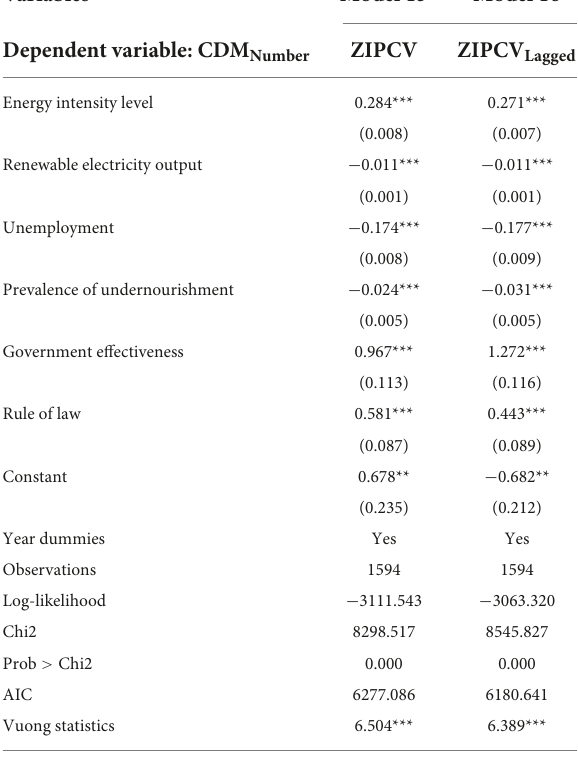
TABLE 9 Results of zero-inflated Poisson with corrected